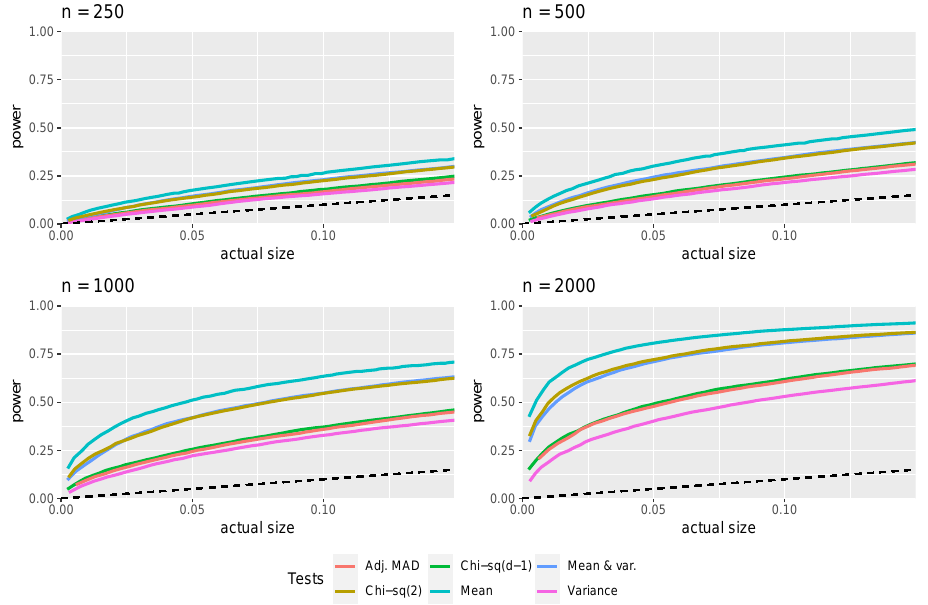
Figure 3. First digit tests: size–power curves of the tests against the uniform mixing alternative with λ = 0.9. Tests are as follows: “Adj. MAD”, adjusted MAD (10); “Chi-sq(2)”, χ 2 ( 2 ) test on the mean and variance (4); “Chi-sq(d-1)”, χ 2 ( 8 ) test (9); “Mean”, normal test on the mean (1); “Mean & var.”, normal test on mean and variance (3); “Variance”, normal test on variance (2). The dashed line is power = actual size . The number of observations is indicated on top of each